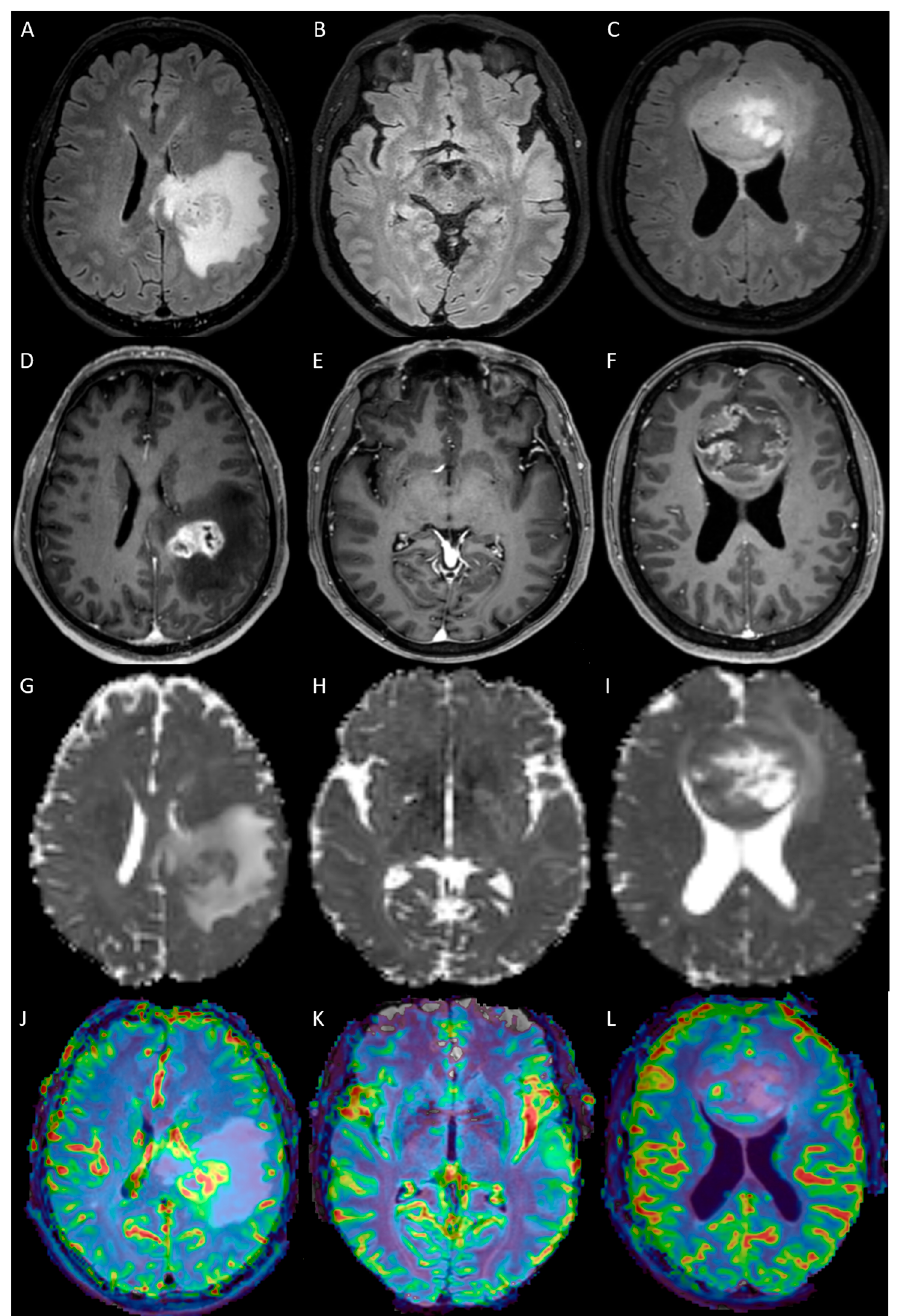
Figure 3. Preoperative MR images of three patients with WHO CNS grade 4 gliomas. The first column shows an example of an astrocytoma of WHO CNS grade 4 ( IDH mutant). The second column shows images of a patient with only molecularly defined glioblastoma ( IDH wild type). Note that there is no visible contrast enhancement in the contrast-enhanced T1-weighted image ( D – F ). In contrast, the third column depicts a case of “classical” glioblastoma showing typical irregular contrast enhancement surrounding a necrotic tumor core. The sequences depicted are T2-FLAIR ( A – C ), contrast-enhanced T1-weighted imaging ( D – F ), apparent diffusion coefficient maps ( A , C , D , G – I ), and leakage-corrected relative cerebral blood volume maps (rCBV, ( J – L